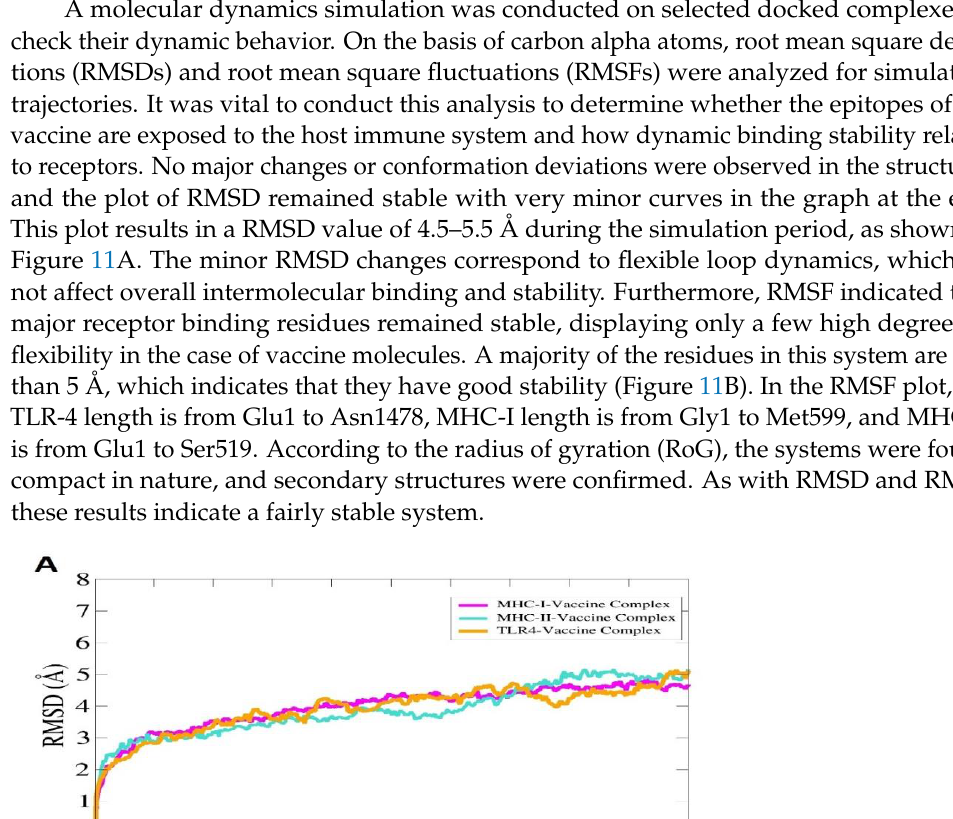
Table 9. Vaccine molecules interact with receptor residues.